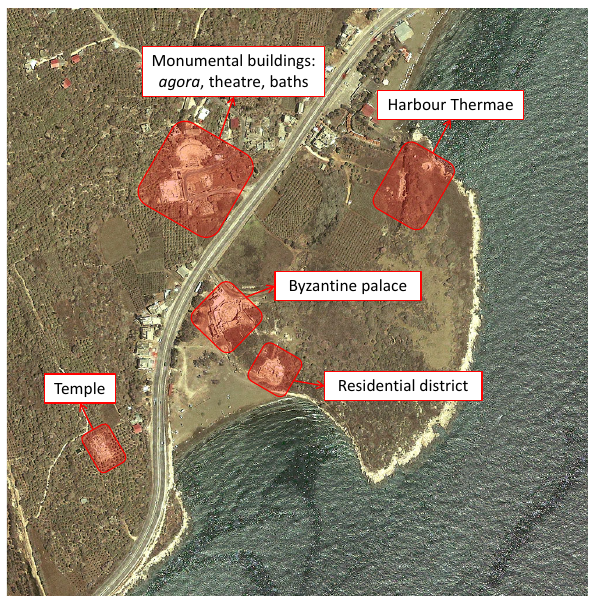
Figure 2. The main excavation areas of Elaiussa Sebaste.